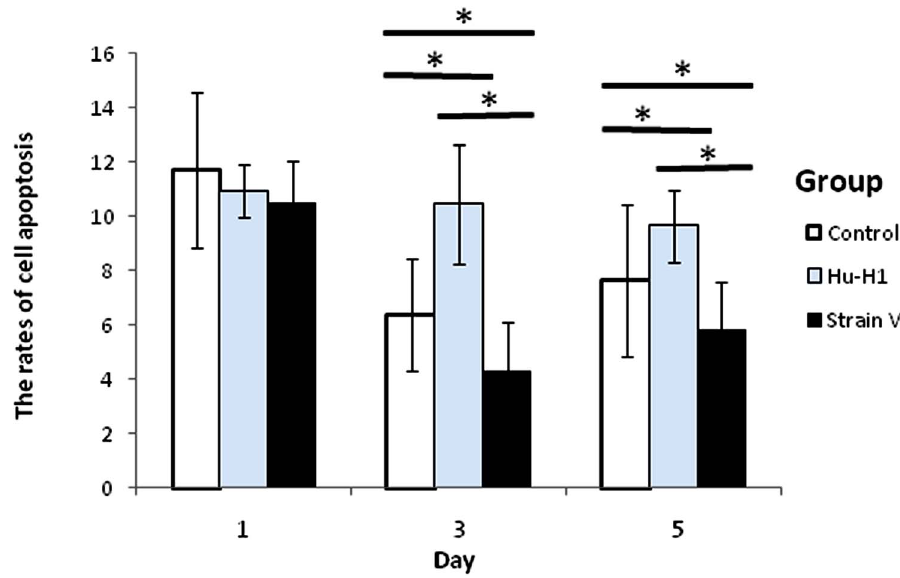
Figure 6. Rates of apoptosis in Hu-H1, Strain V, and control cells. * p , 0.05.